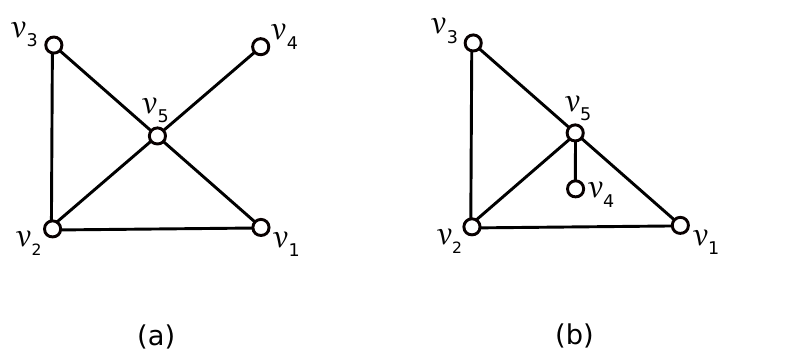
Figure 2. Two possible non isomorphic planar drawings of the graph G 11 . ( a ) The planar drawing of G 11 with five vertices in one region; ( b ) the planar drawing of G 11 with at most four vertices in one